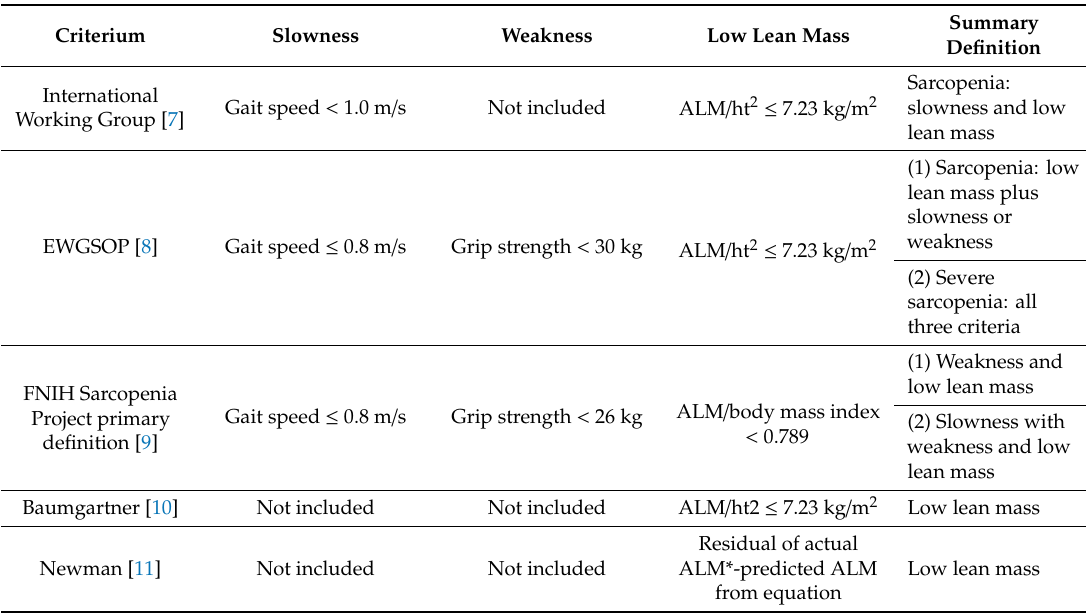
Table 1. Di ff erent criteria for the diagnosis of